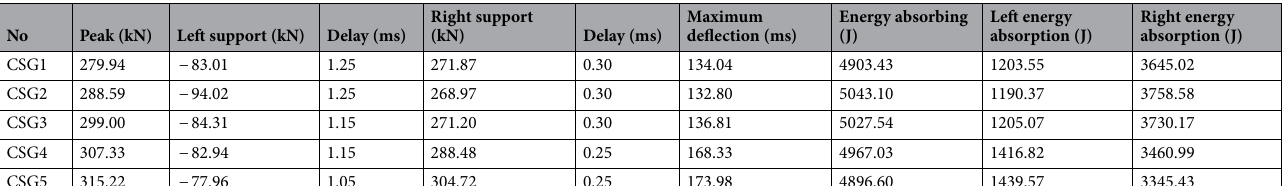
No Peak (kN) Left support (kN) Delay (ms)